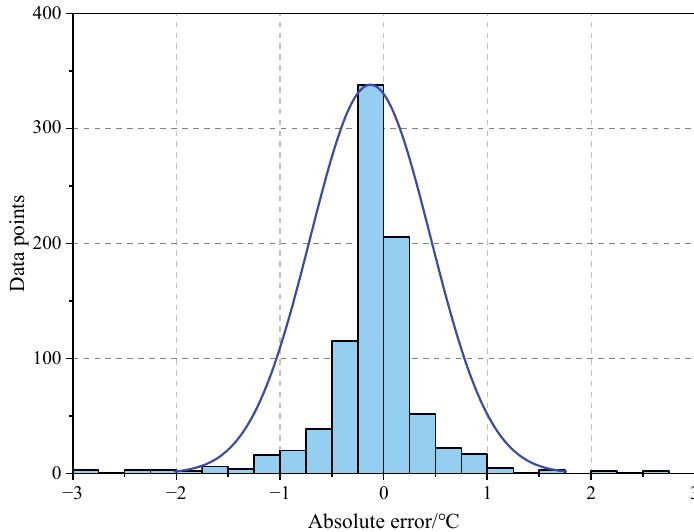
Figure 13. The error of the predicted and observed values.